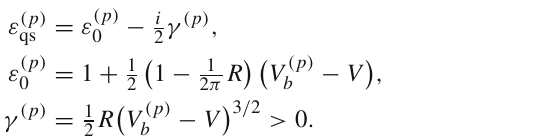
the upper continuum boundary. Indeed, in this case hence according to (12) we